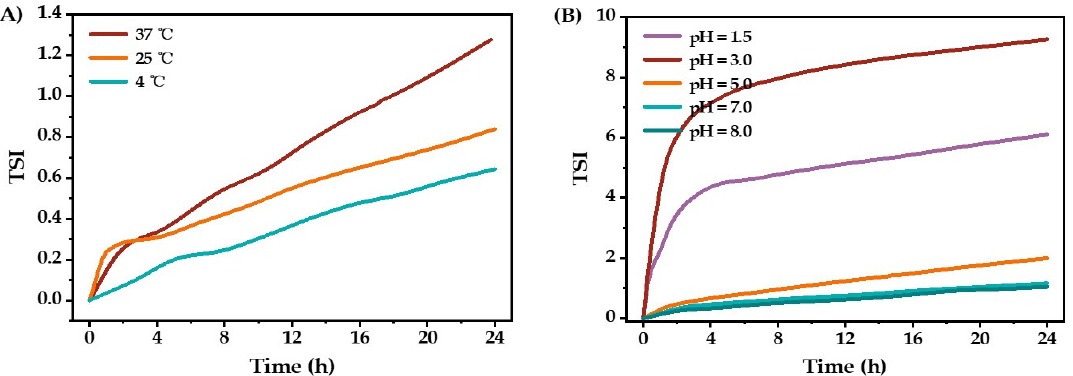
Figure 9. The stability of the optimized O/W emulsion under different temperatures ( A ) and pH ( B ). 2.4. Storage Stability of Curcumin Encapsulated in the O/W